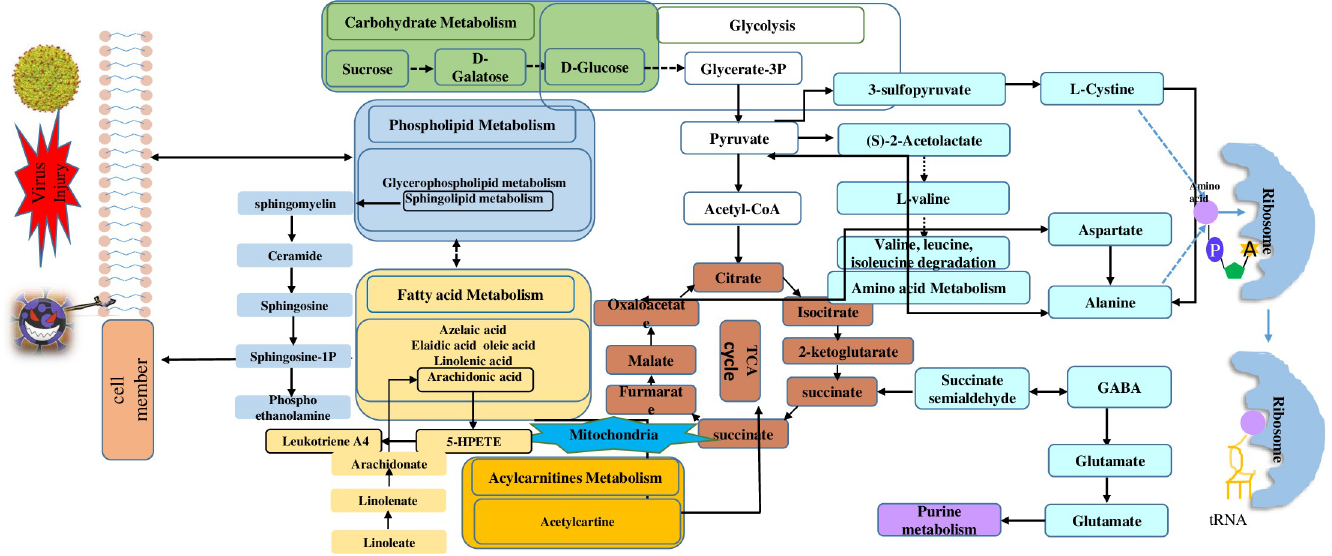
Fig 2. Major altered lipid and energy metabolic pathways in TBEV patients.